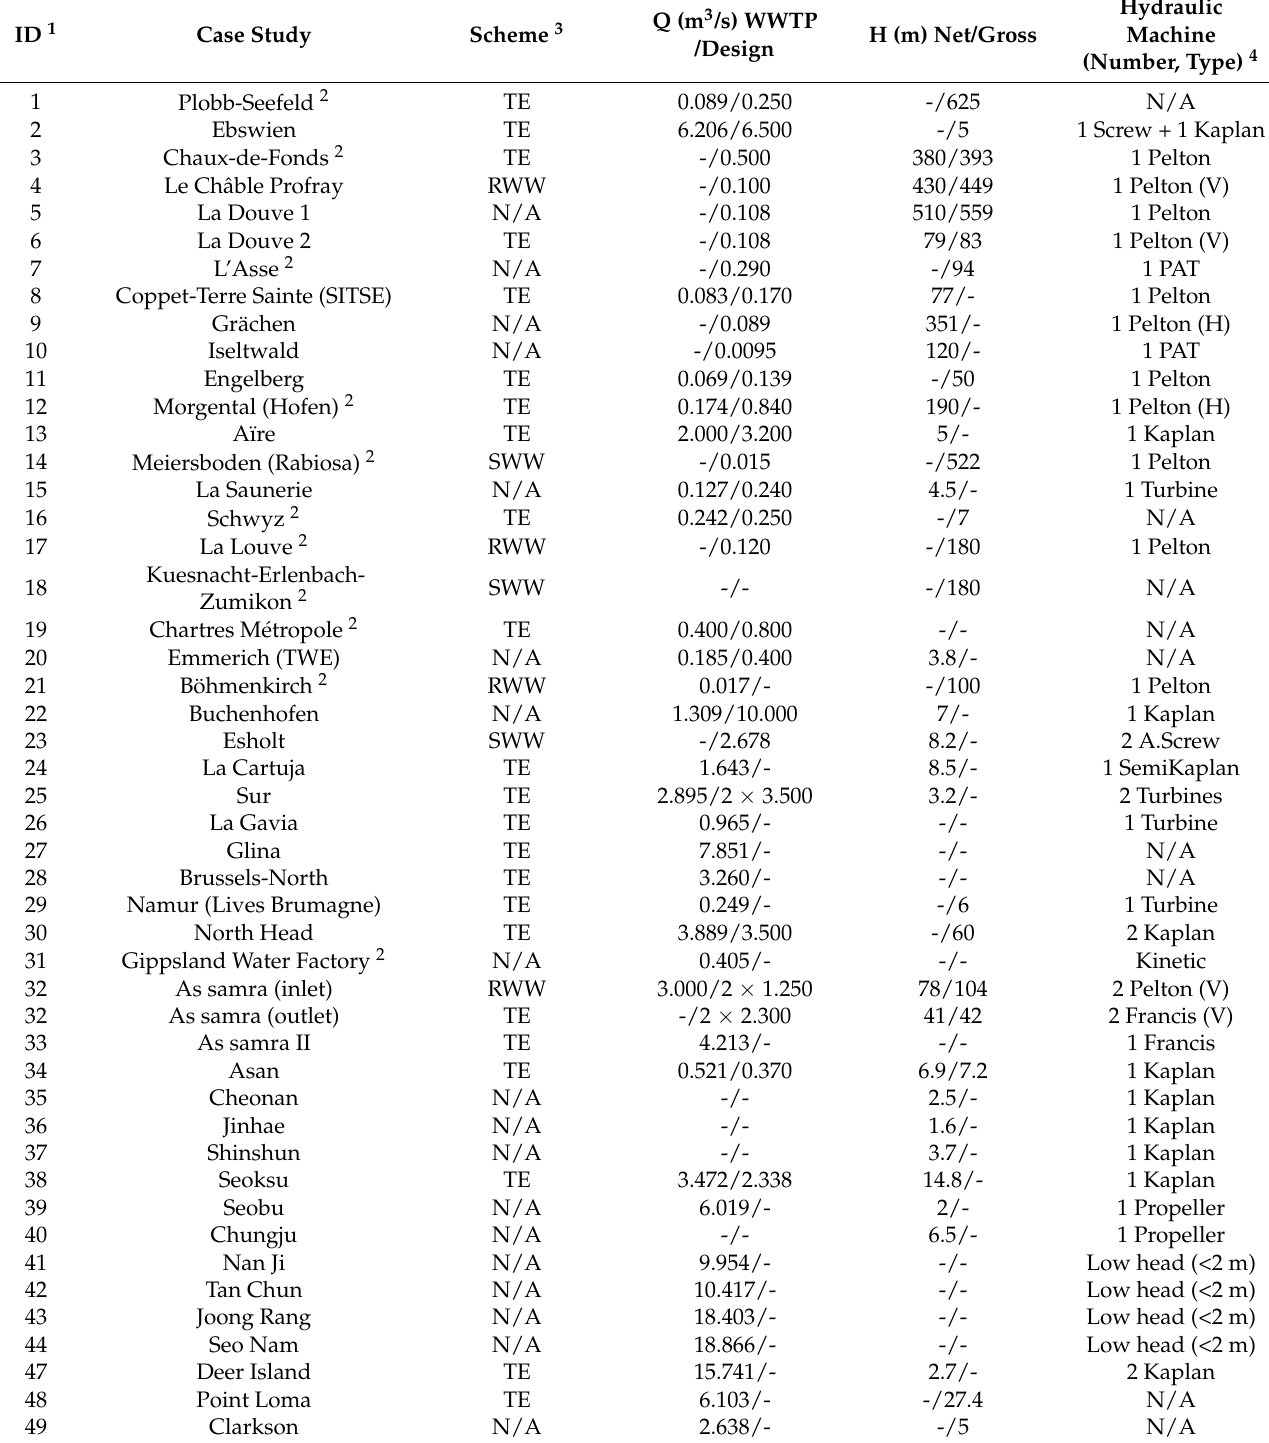
Table 3. Technical data of hydropower systems installed in real cases studies found during this